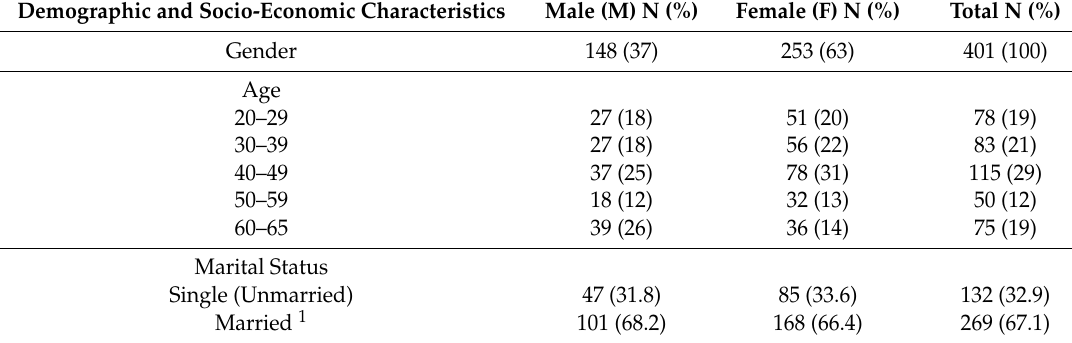
Table 2. Socio-demographic characteristics and anthropometric measurement vary by gender. Demographic and Socio-Economic